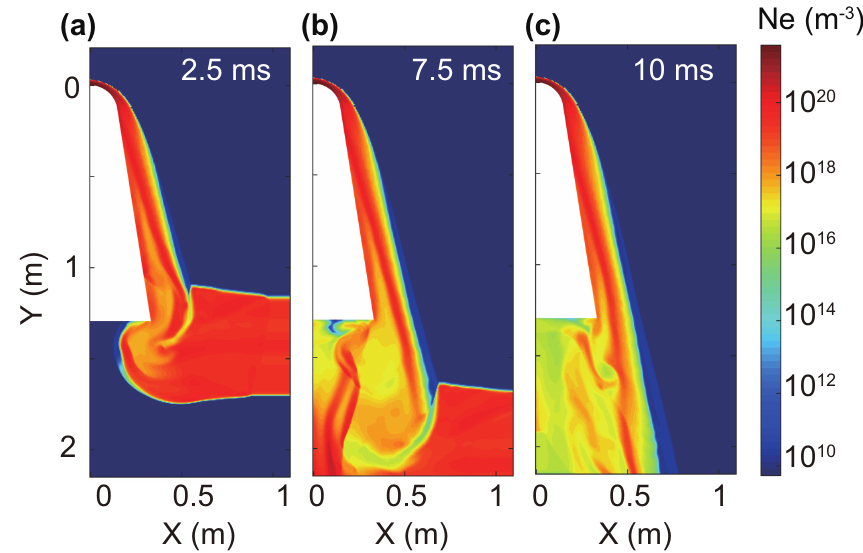
Figure 3. The evolution of the plasma sheath at ( a ) 2.5 ms, ( b ) 7.5 ms, and ( c ) 10